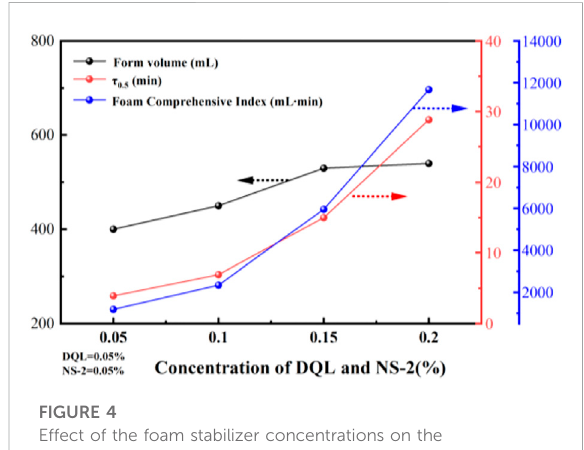
FIGURE 4 Effect of the foam stabilizer concentrations on the performance of the 0.5% CQS-1 foam